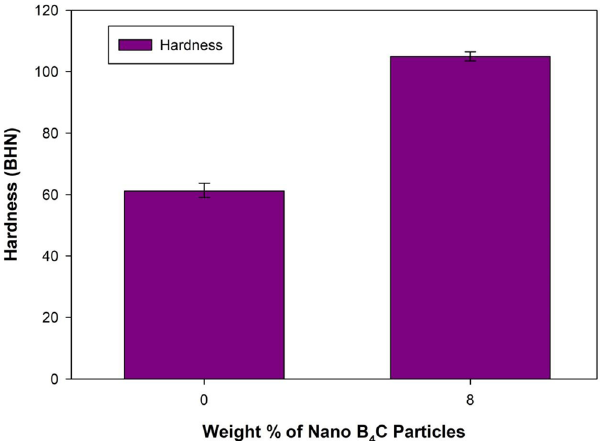
Fig. 8. Hardness of Al2214alloy and B 4 C reinforced